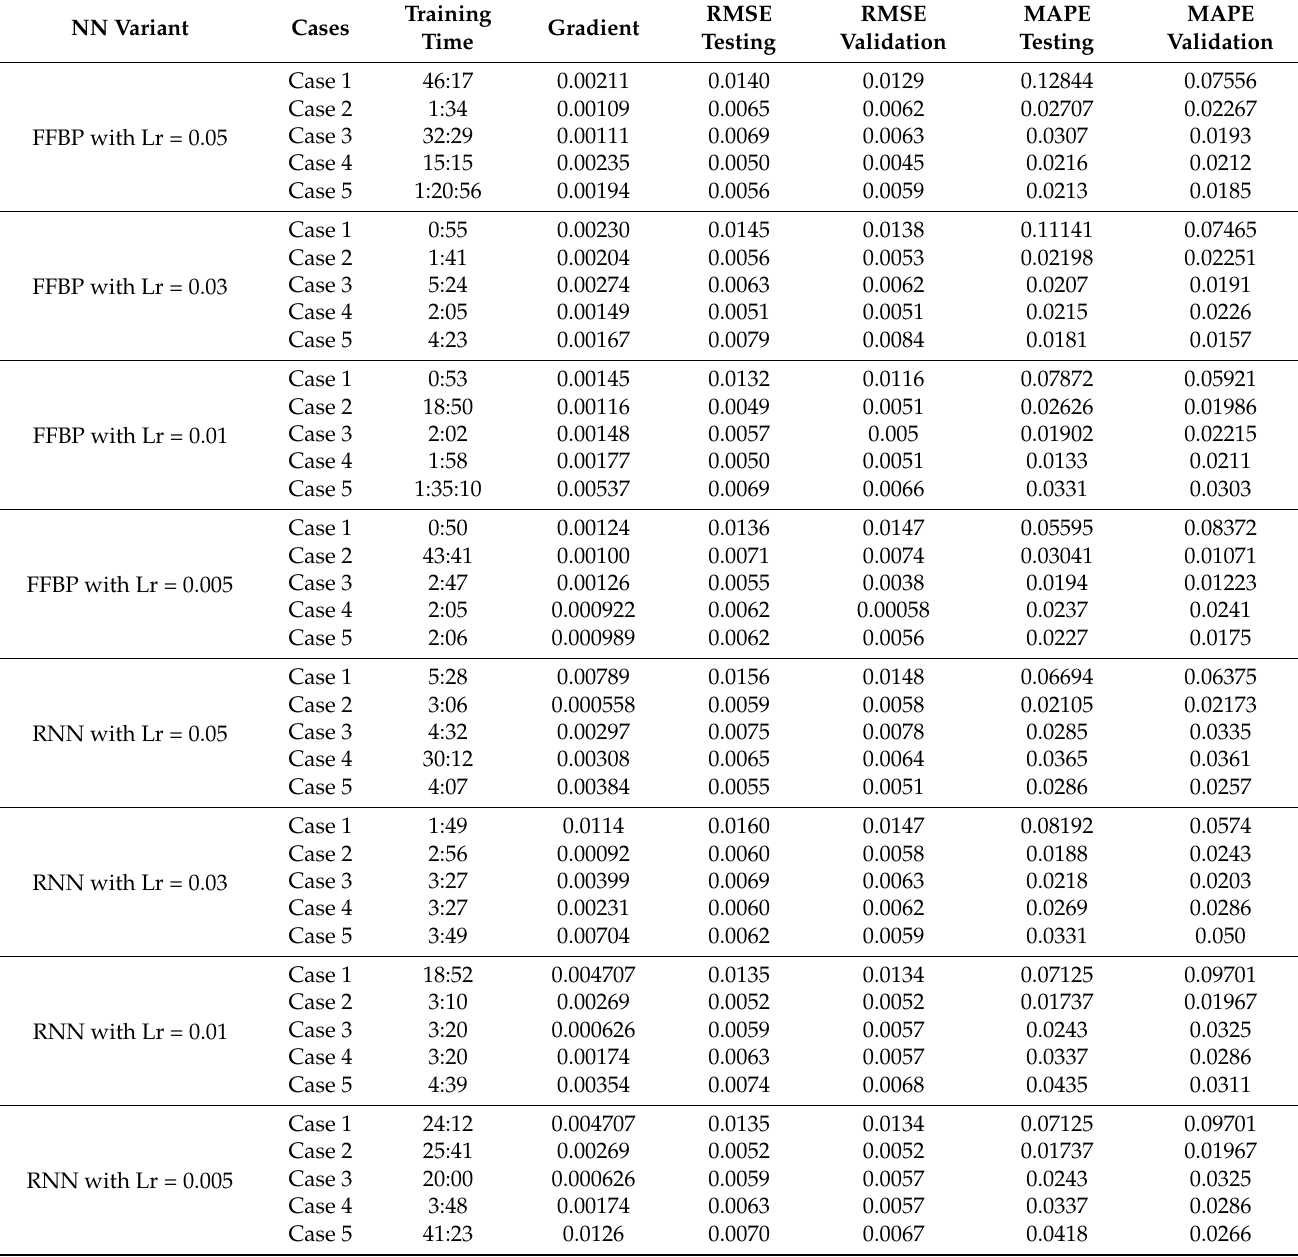
Table 9. Training and testing results of FFBPNN and RNN for all